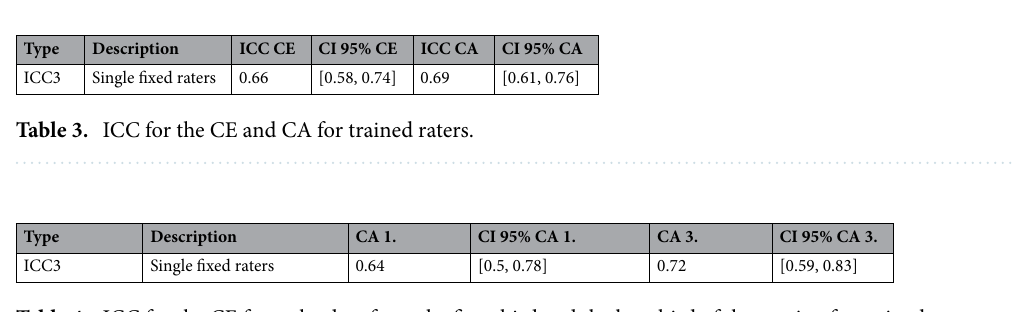
Table 4. ICC for the CE from the data from the first third and the last third of the scoring for trained